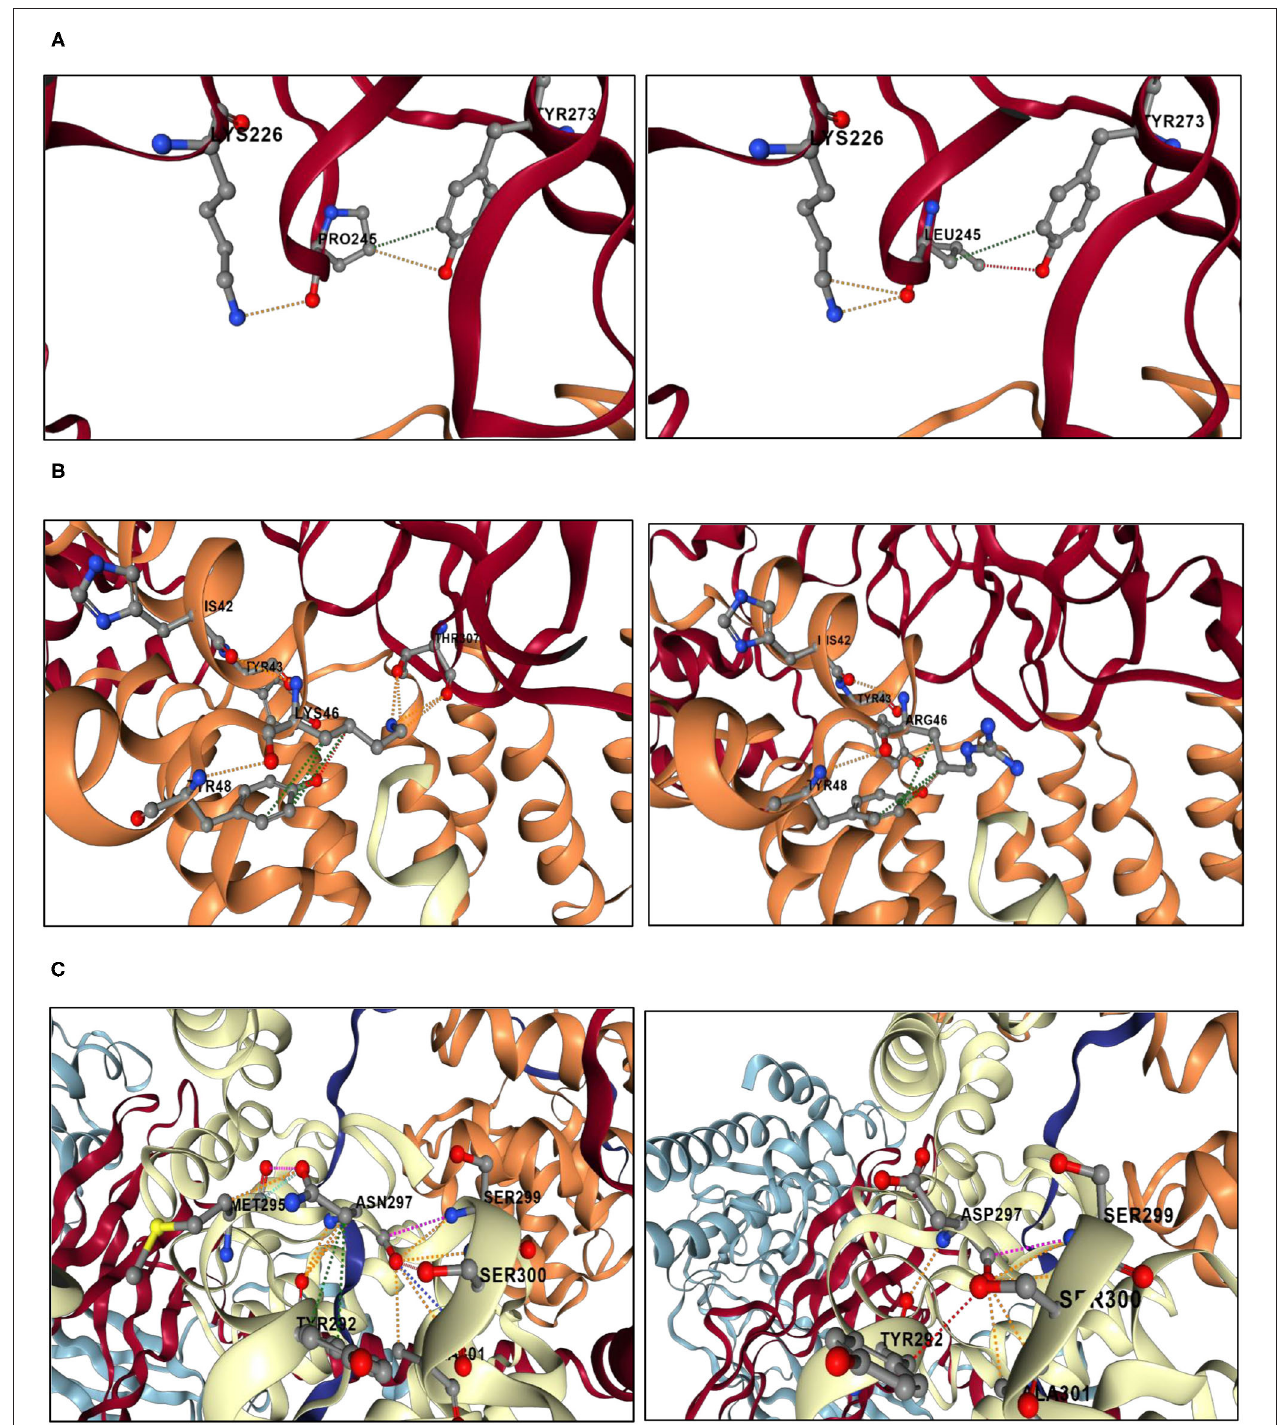
FIGURE 3 | Structural analyses results of the genetic variants located in the BBSome. The analyses were performed using DynaMut2 server. (A) Structural analysis of the BBS1 p.Pro245Leu mutation. A fraction of BBS1 subunit is shown in red. A fraction of BBS4 is shown in orange. The left panel shows a close-up view of the interactions between Pro245 and the surrounding residues. Orange dashes represent polar bonds between Pro245 and Tyr273 and Lys226. Green dashes represent hydrophobic interaction bond between Pro245 and Tyr273. Oxygen atoms are colored in red, nitrogen atoms are colored in blue, and carbon atoms are colored in gray. The right panel shows a close-up view of the interactions between Leu245 and the surrounding residues. The mutant residue Leu245 replaces the polar bonds